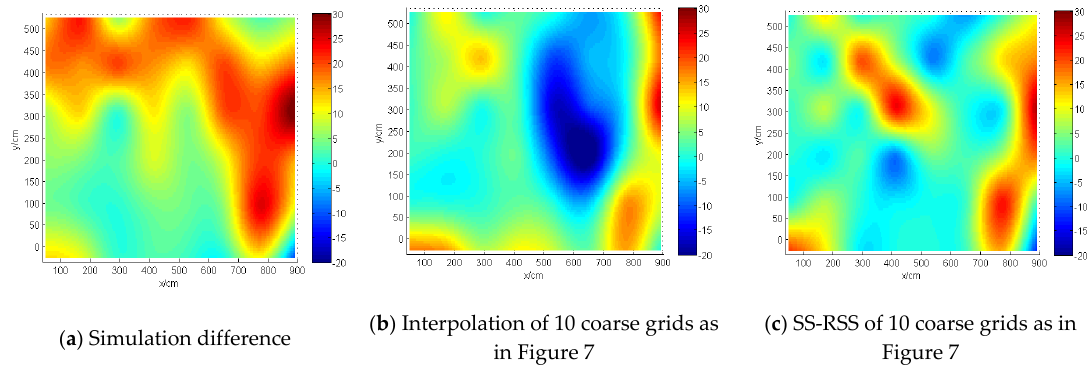
Figure 8. Two dimensions (2D) heat map of the Wi-Fi RSS distribution from one AP of four fingerprinting database conduction methods.